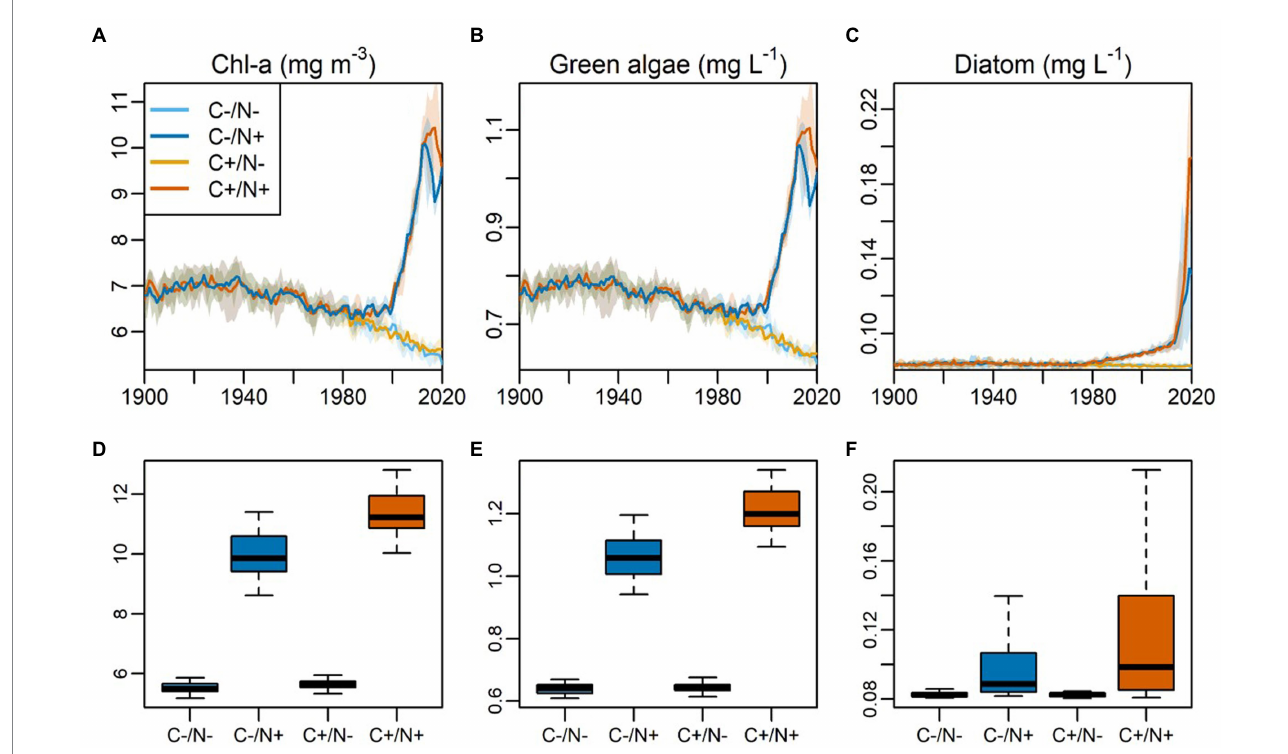
FIGURE 6 Model simulated annual averaged, volume-weighted data across the water column for (A) Chl a concentration (B) biomass of green algae, (C) biomass of diatom, from 1900 to 2020 under different scenarios. The scenarios are composed for a two-factorial approach. ‘C’ denotes the climate factor (‘C-’ is the ‘piControl’ climate scenario without anthropogenic change, and ‘C+’ is the ‘historical’ with climate change). ‘N’ denotes the nutrient loading factor (‘N-/N+’ represents the scenarios without and with the rapid increase of atmospheric N deposition after ca. 2000s). The shade area represents the modeling range derived from the four Global Climate Models (GCMs) from the ISIMIP project. (D–F) The corresponding boxplots of the variable above during 2000–2020 under various modeling